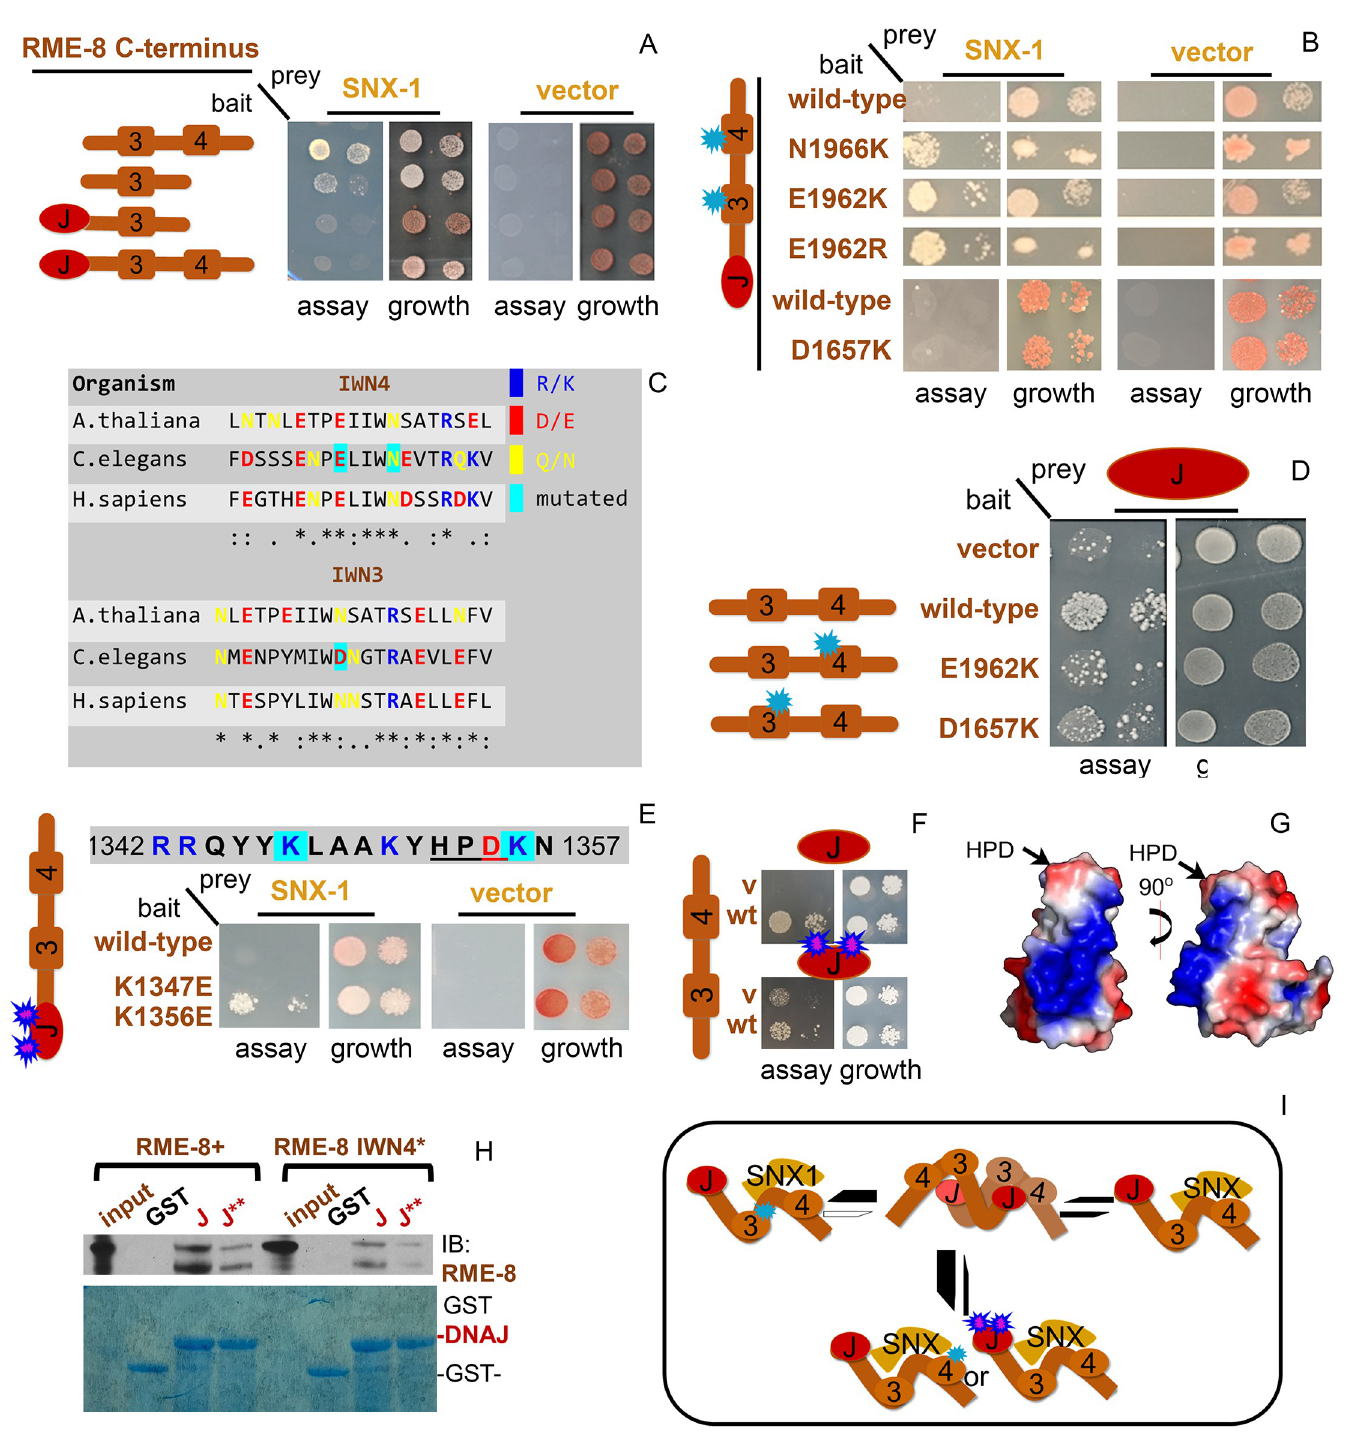
Fig 4. The RME-8 DNAJ, IWN4, and IWN3 domains mediate SNX-1 and RME-8 self-interactions. (A) SNX-1 (aa221-472) expressed in pDEST22 tested for interaction with empty vector or fragments of the RME-8 C-terminus expressed in pDEST32 using JDY27 containing URA3, ADE2, and HIS3 reporter genes. 5ul of suspended yeast at 1, and 0. 1 OD’s s were spotted on SC-LEU-TRP growth or SC-LEU-TRP-URA assay media. A schematic representation of the RME-8 fragments tested are illustrated to the left of the yeast two hybrid assay. (B) PCR mutagenesis of the RME-8 (DNAJ-end) fragment yielded two mutants in IWN4. Both mutations were lysine substitutions at Glutamic Acid 1962 and Asparagine 1966, that enabled an RME-8(C-term)/SNX-1(BAR) growth on the stringent assay media SC-LEU-TRP-URA. An arginine substitution at position 1962 also enabled growth on the stringent assay media SC-LEU-URA. An analogous IWN4 mutation as was found to alter SNX-1 interaction was